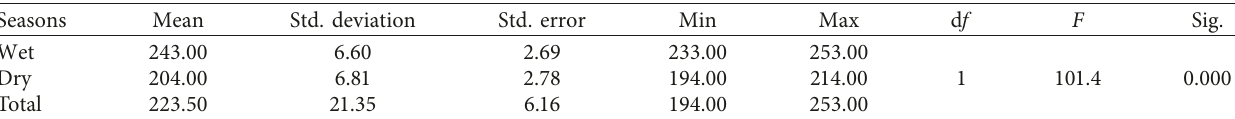
Table 3: The statistical analysis of wild mammals’ population in the wet and dry season in Tisiki